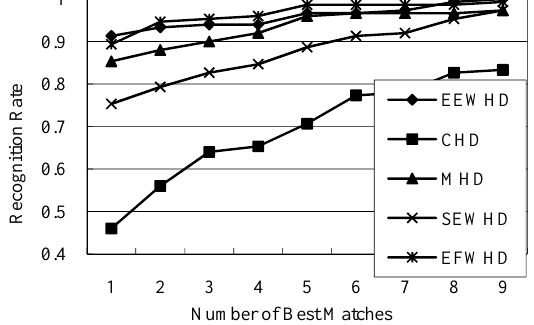
Fig. 5 Comparison of the accumulative recognition rates of different Hausdorff distance measures SEWHD calculates PCA on grayscale images and